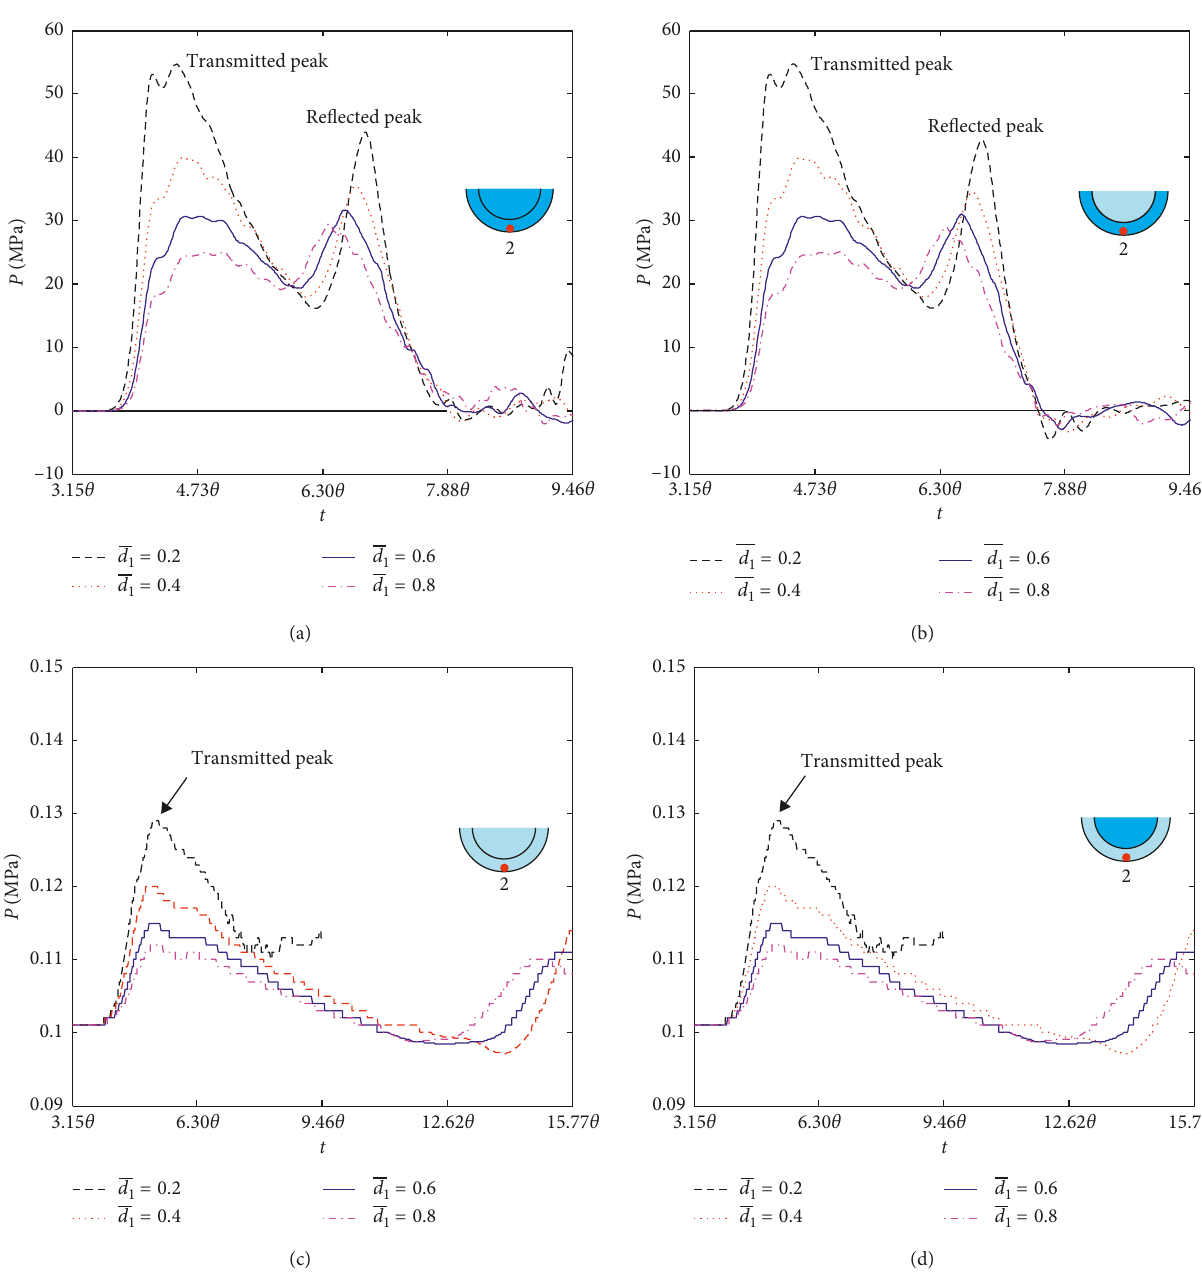
Figure 16: Transmitted pressure at gauging point 2 for different media filled between the shells (dark color represents water and light color represents air). (a) Water-water. (b) Water-air. (c) Air-air. (d)